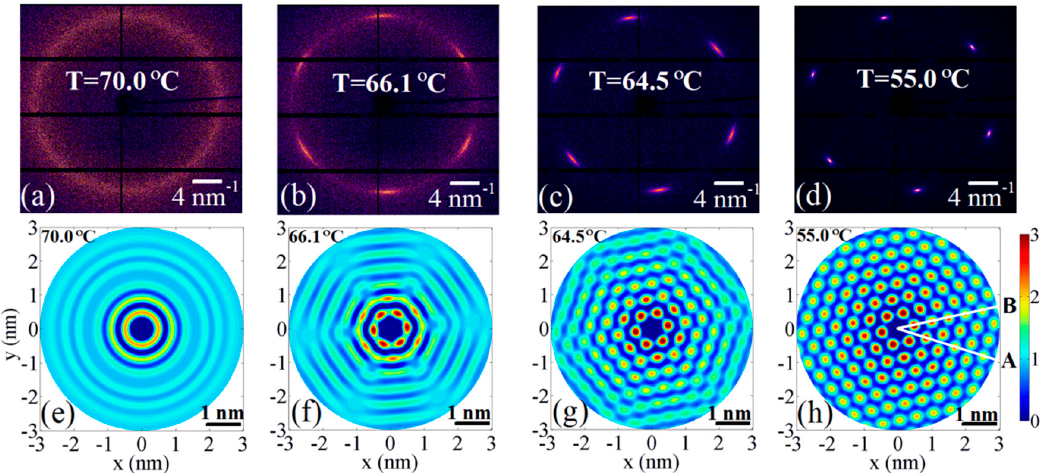
Figure 11. ( a – d ) Measured diffraction patterns from 3(10)OBC LC compound above ( a ) and below ( b – d ) the Sm-A–Hex-B phase transition. ( e – h ) Corresponding reconstruction of the 2D pair distribution function (PDF). Development of the BO order and increase of the positional correlation length is visible in ( f – h ). (adopted from Zaluzhnyy et al. [76]). Reproduced with permission of American Physical Society.